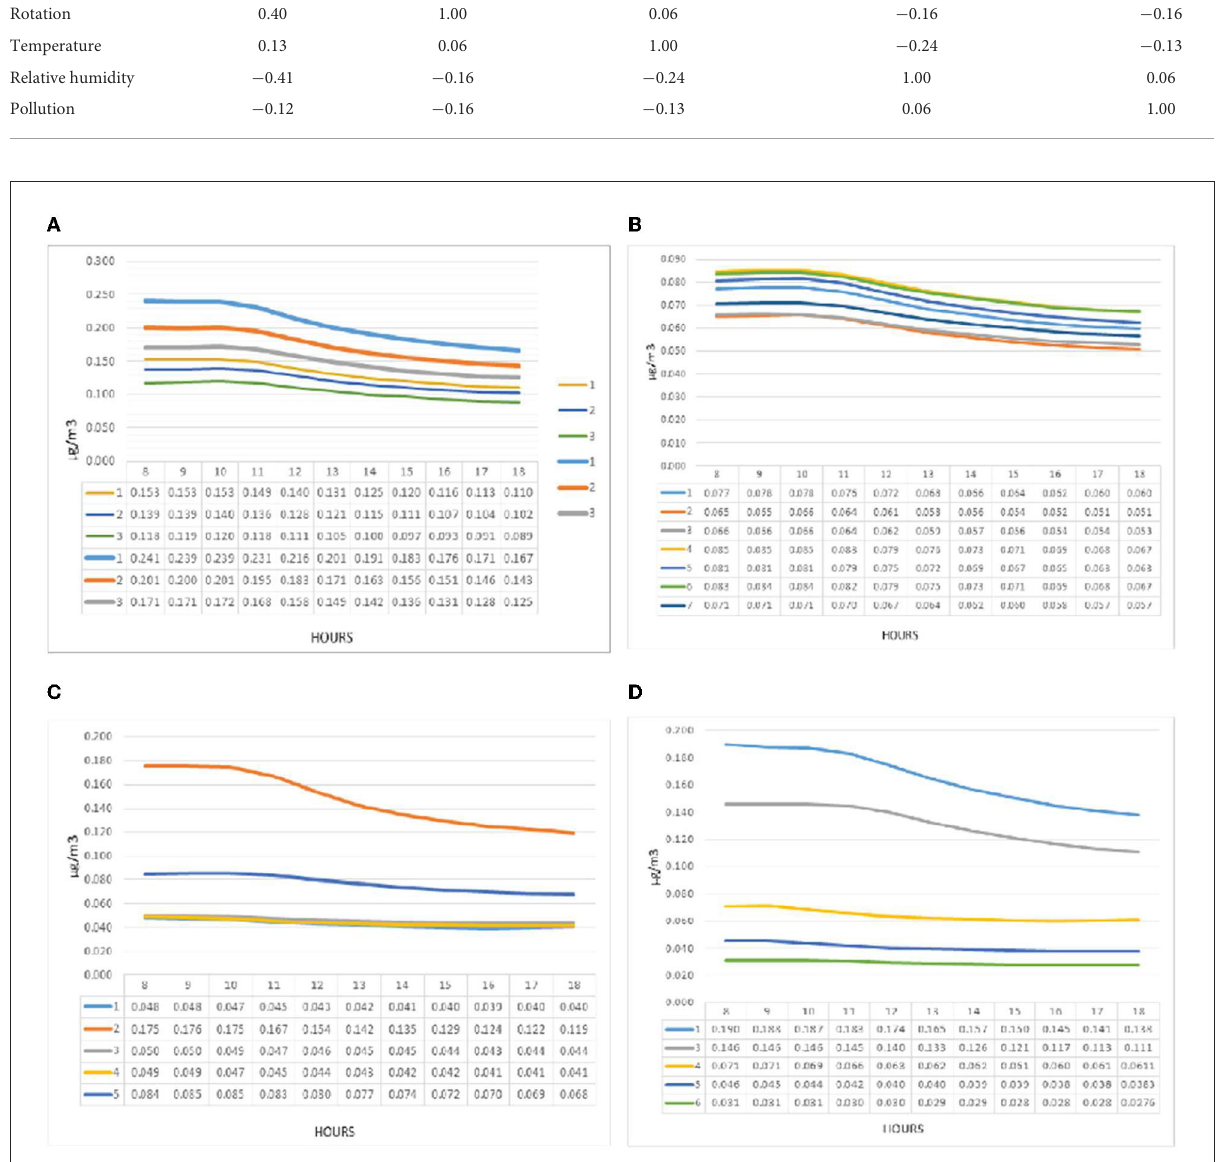
FIGURE9 (A–D) Pollution concentration diagrams from point B in all groups, respectively.